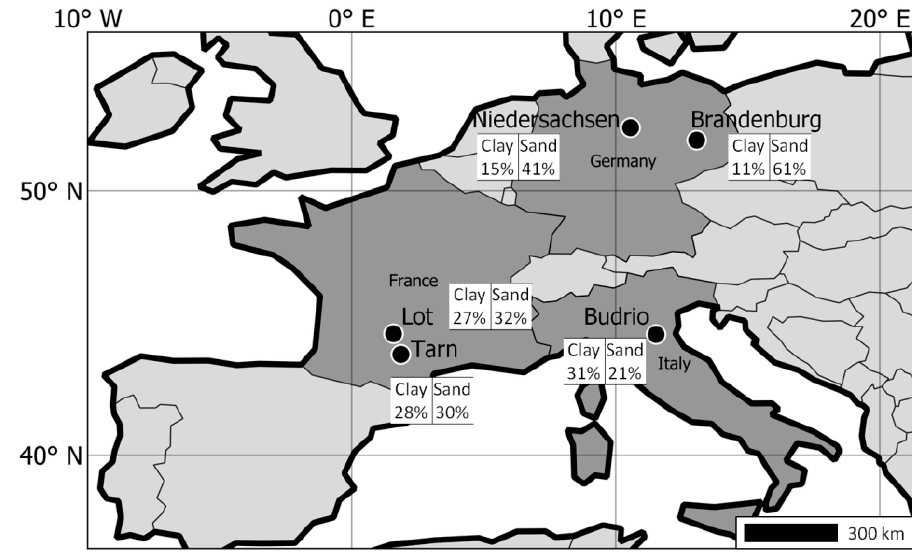
Figure 1. Regions location and average soil texture from the dataset’s fields. Table 1. The number of seasons per crop and region in the dataset.